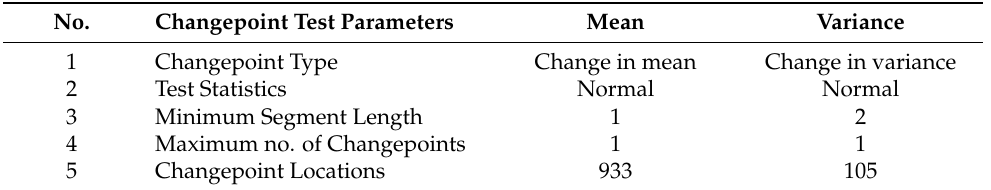
Table 2. Changepoints of the WED data series for the mean and variance.